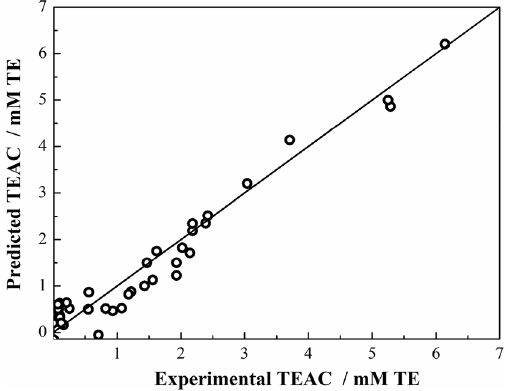
Figure 1. Correlation of experimental and predicted activity of agonists using Eq.